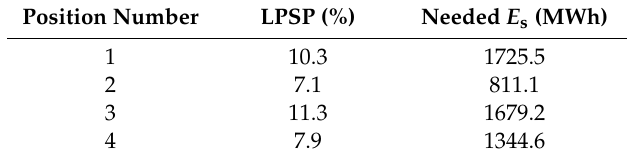
Table 8. LPSP results using a probabilistic approach (1 day continuing the power deficit).